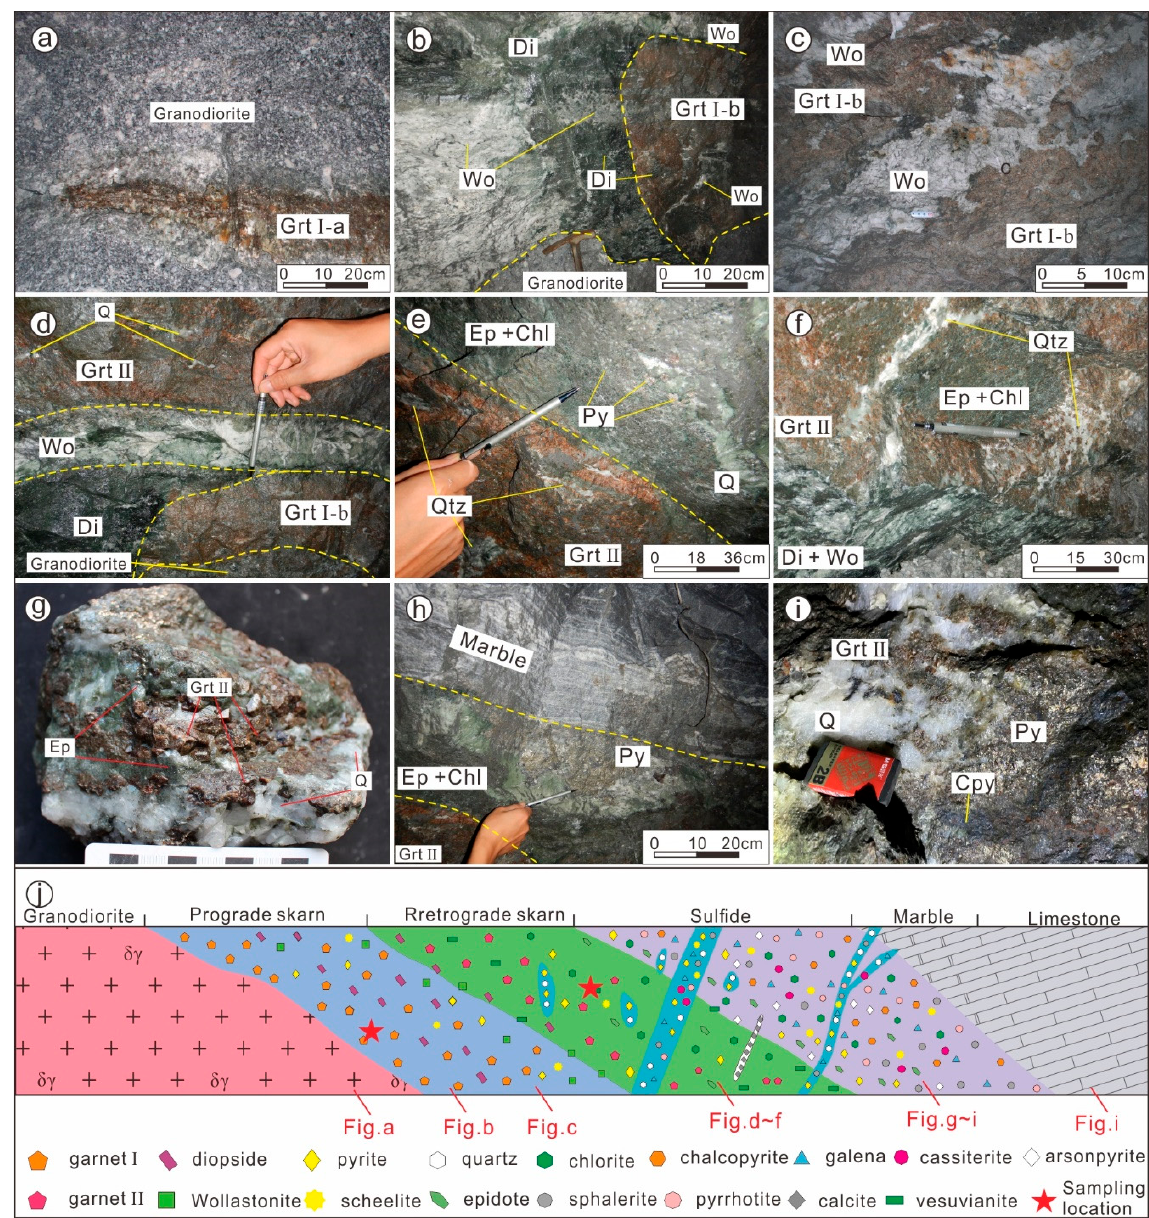
Figure 4. The photographs show the mineralized alteration zonation characteristics of the Tongshanling deposit from granodiorite to limestone and from close-range to far-range: ( a ) Grt I-a associated to granodiorite, ( b ) Grt II-b associated with diopside, wollastonite, and granodiorite, ( c ) wollastonite strip-through-cut Grt I-a, ( d ) Spatial relationship between Grt I-a associated to granodiorite, Grt I-b and Grt I, visible diopside and wollastonite minerals, ( e ) Retrometamorphic Grt II associated with chlorite, epidote, quartz, and mineralization, ( f ) Grt II associated with chlorite, epidote, and quartz, ( g ) Grt II associated with chlorite, epidote, and quartz, ( h ) Photographs of Grt II, sulfide stage, marble, and limestone zonation, ( i ) zonation of sulfide and marble, with obvious pyrite and spha- lerite, etc., ( j ) Schematic diagram of the Tongshanling deposit’s zonation characteristics. Grt = garnet, Di = diopside, Wo = wollastonite, Q = quartz, Py = pyrite, Ep = epidote, Chl = chlorite, Sp =